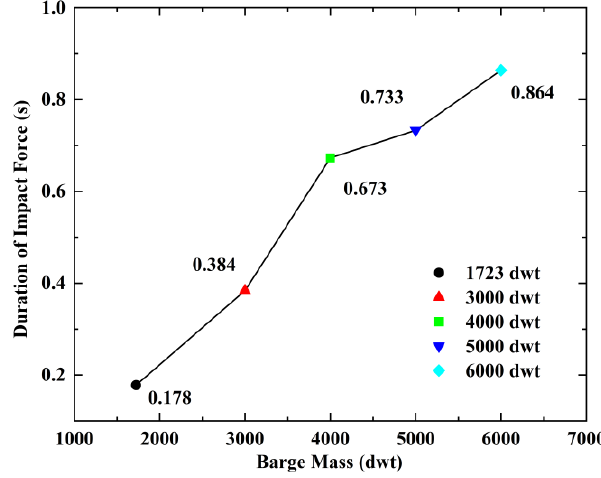
Figure 21. Collision durations under different barge masses.